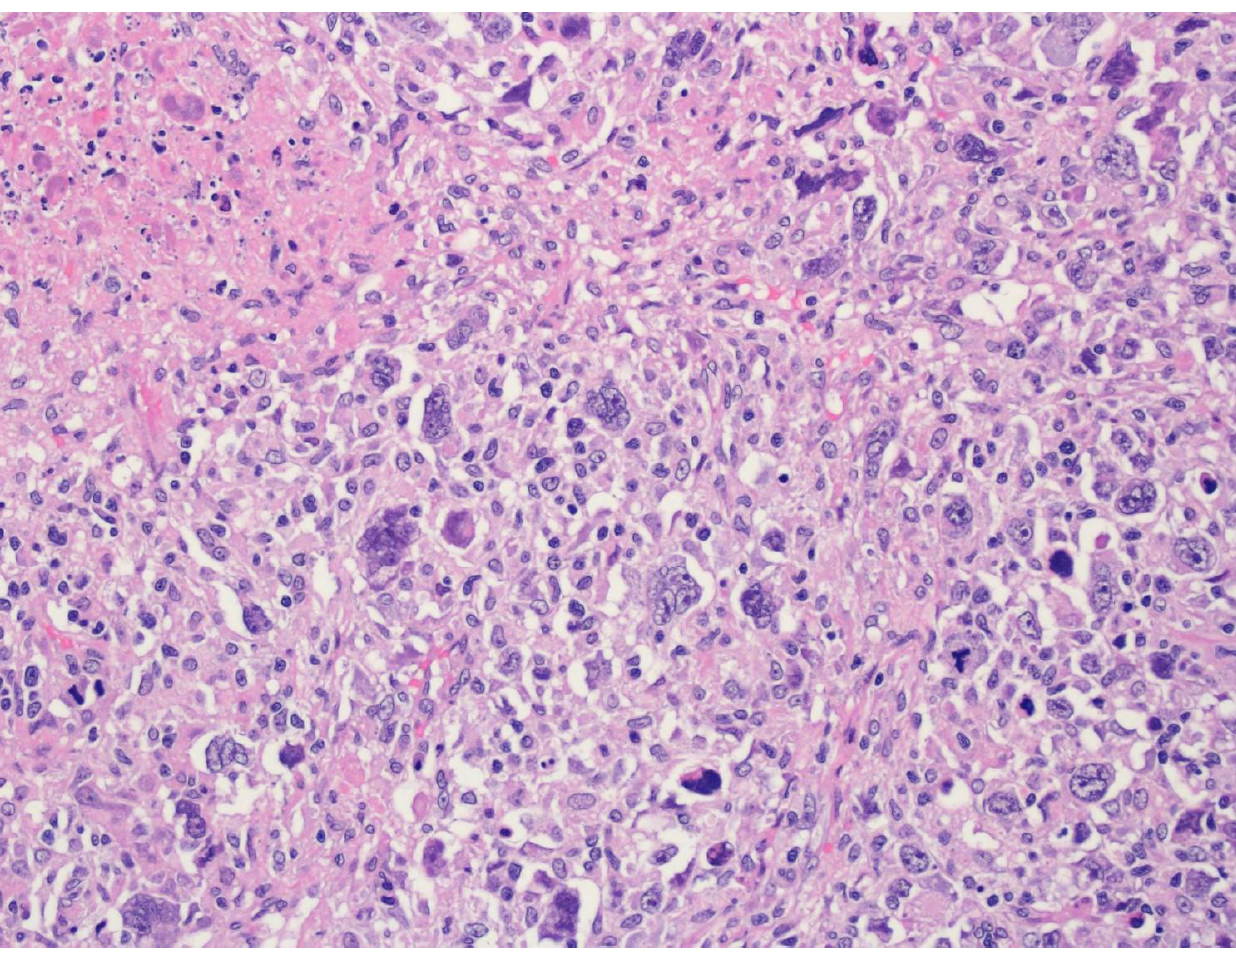
Figure 7. EBV-positive diffuse large B-cell lymphoma (H&E ×400). This lymphoid tumor shows numerous anaplastic Hodgkin- and Reed – Sternberg-like cells. Upon EBER in situ hybridization, practically all nuclei were positive. On the upper left, an area of necrosis is seen.